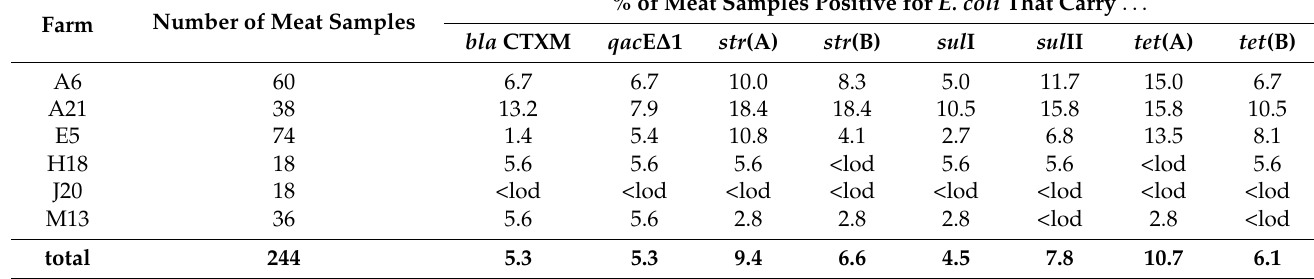
Table 15. Prevalence of E. coli that carried antimicrobial resistance genes in meat samples at slaughter ( n meat samples = 244).